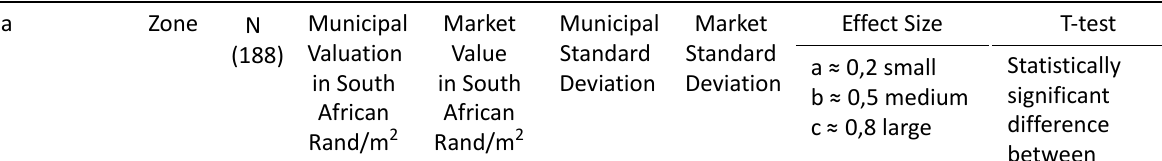
Table 3. Dependent t‐test